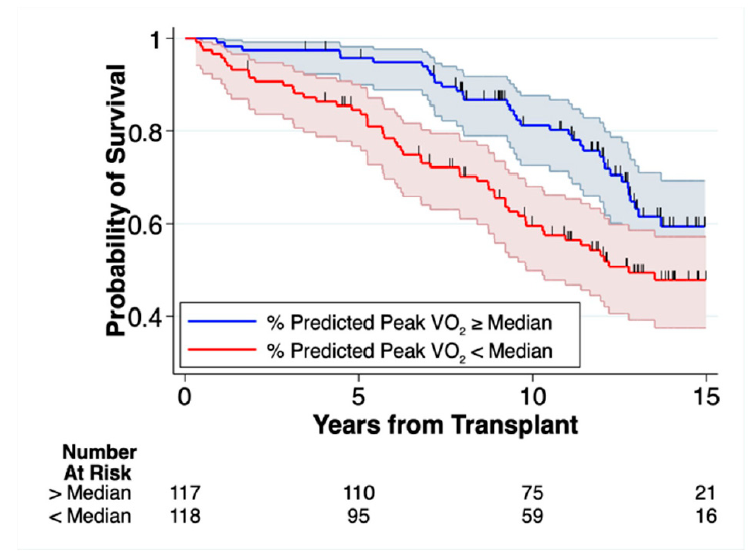
Figure 3. Kaplan–Meier Survival Estimates Stratified by Median % Predicted Peak VO 2 . Patients with post-transplant % Predicted Peak VO 2 (%VO 2 ) below median had significantly lower long-term survival. The median %VO 2 was 49%. Vertical dash marks indicate censored events. Shaded areas represent the 95% Confidence Intervals.